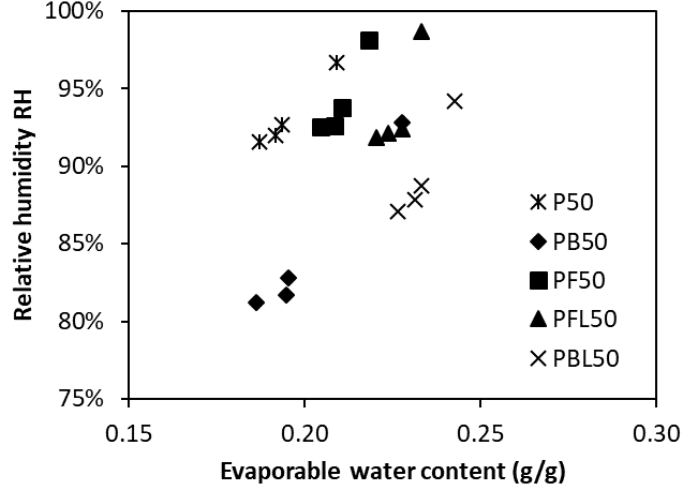
Figure 12. Effect of evaporable water content on relative humidity in various cementitious pastes.